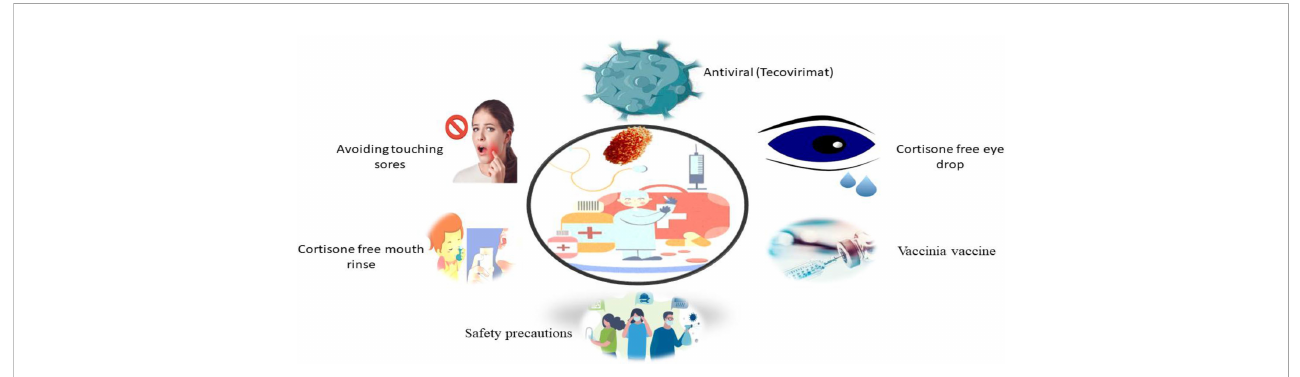
FIGURE 4 Possible treatment of MPX Virus